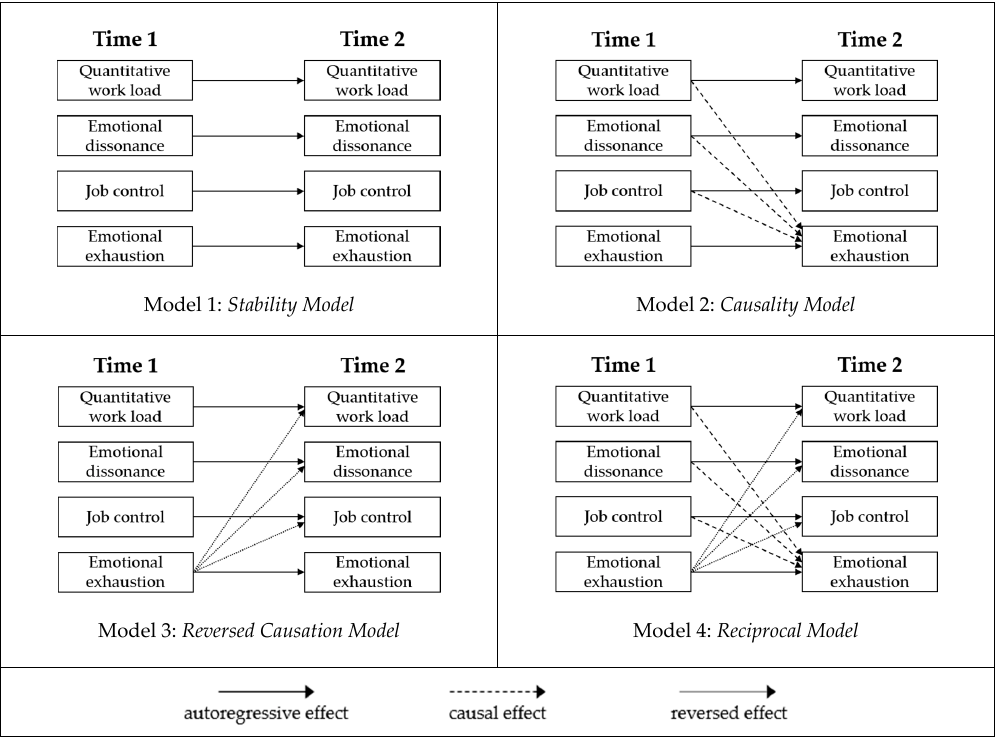
Figure A1. Path models for investigating cross-lagged relationships as suggested by Hakanen and colleagues [55].